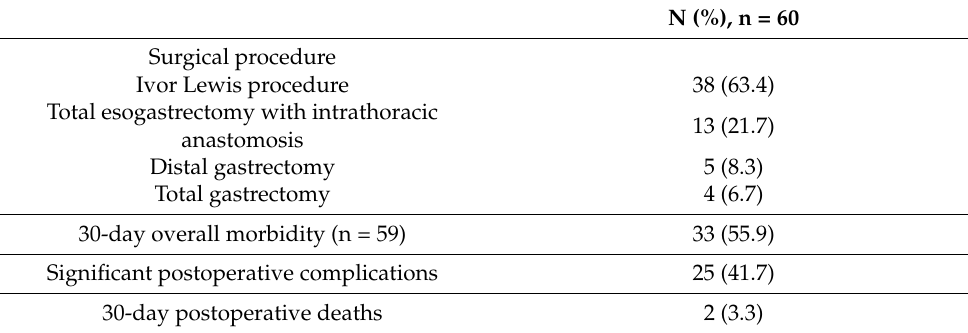
Table 3. Surgical and pathology results in the resected population (n =